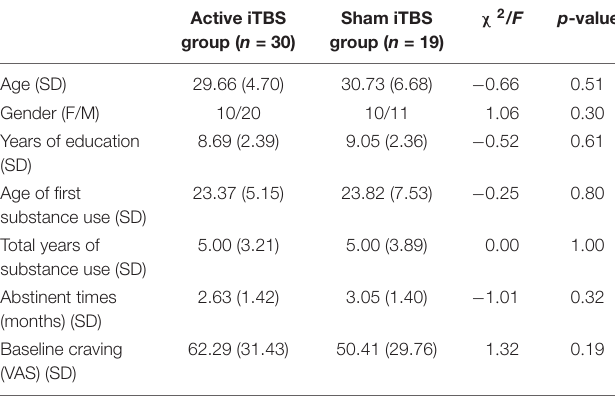
TABLE 1 | Baseline demographic of methamphetamine-dependent patients in two treatment